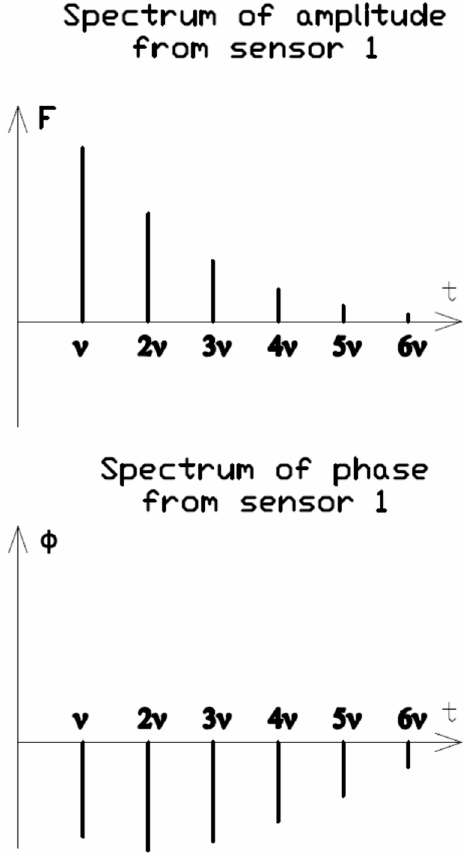
Figure 4. Amplitude and phase spectrum of the first sensor. Since the pulse source is single, the signal reached by both sensors has the same shape,